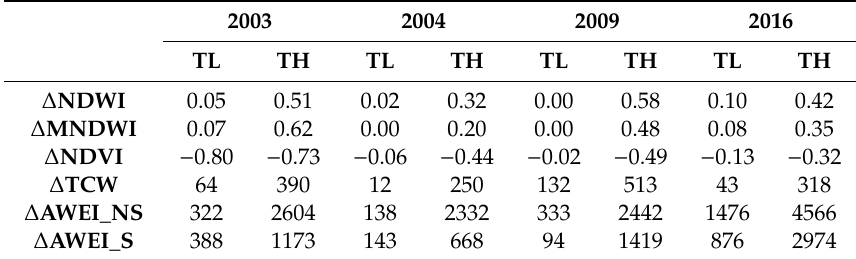
Figure 5. Examples of threshold extraction (TL and TH) analysis from ∆ NDWI, ∆ NDVI and ∆ TCW (for the event of 2003, within the region of interest): ( a ) frequency distribution functions; ( b ) first order derivatives ( df ); ( c ) second order derivatives ( d2f ); ( d) spatial representation of ∆ WrI after thresholding (Coordinate System: PT-TM06/ETRS89). Table 6. Thresholds of each ∆ WrI, for every selected